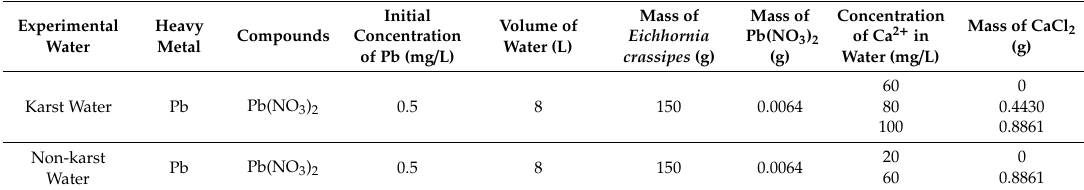
Table 2. Experimental parameters of the e ff ects of calcium ion (Ca 2 + ) concentrations on Eichhornia crassipes absorbing lead (Pb) in